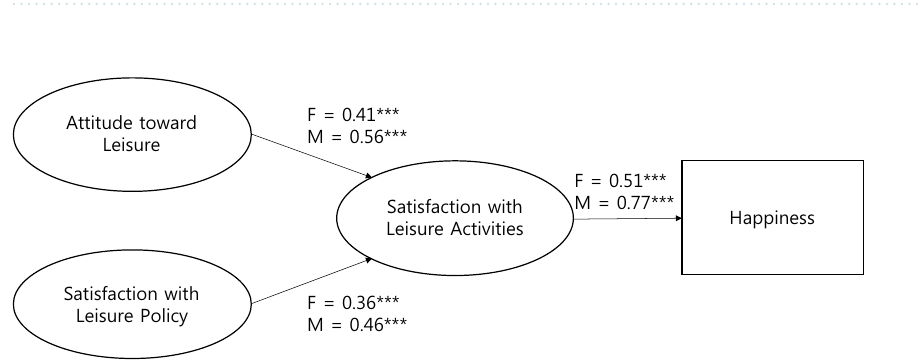
Table 6. Comparison of female and male group differences between the baseline model and models with equality constraints on the path coefficients.